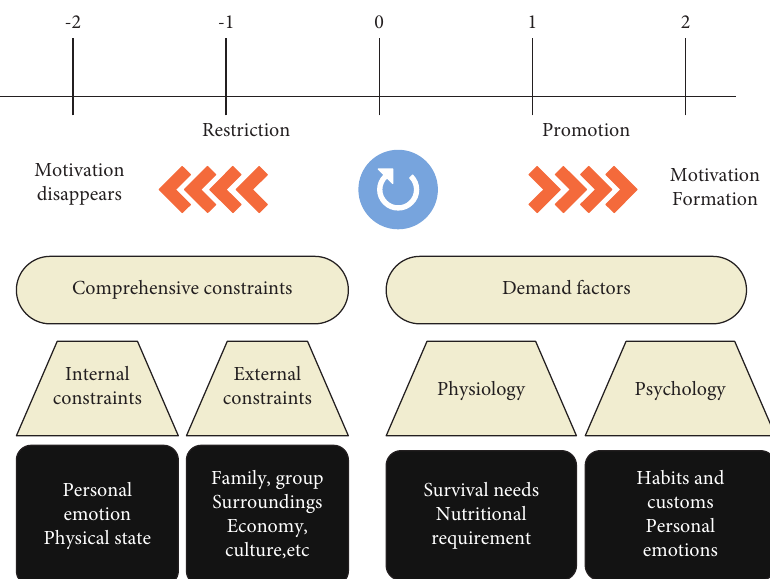
Figure 8: The influencing factors and mechanism of the formation of buying